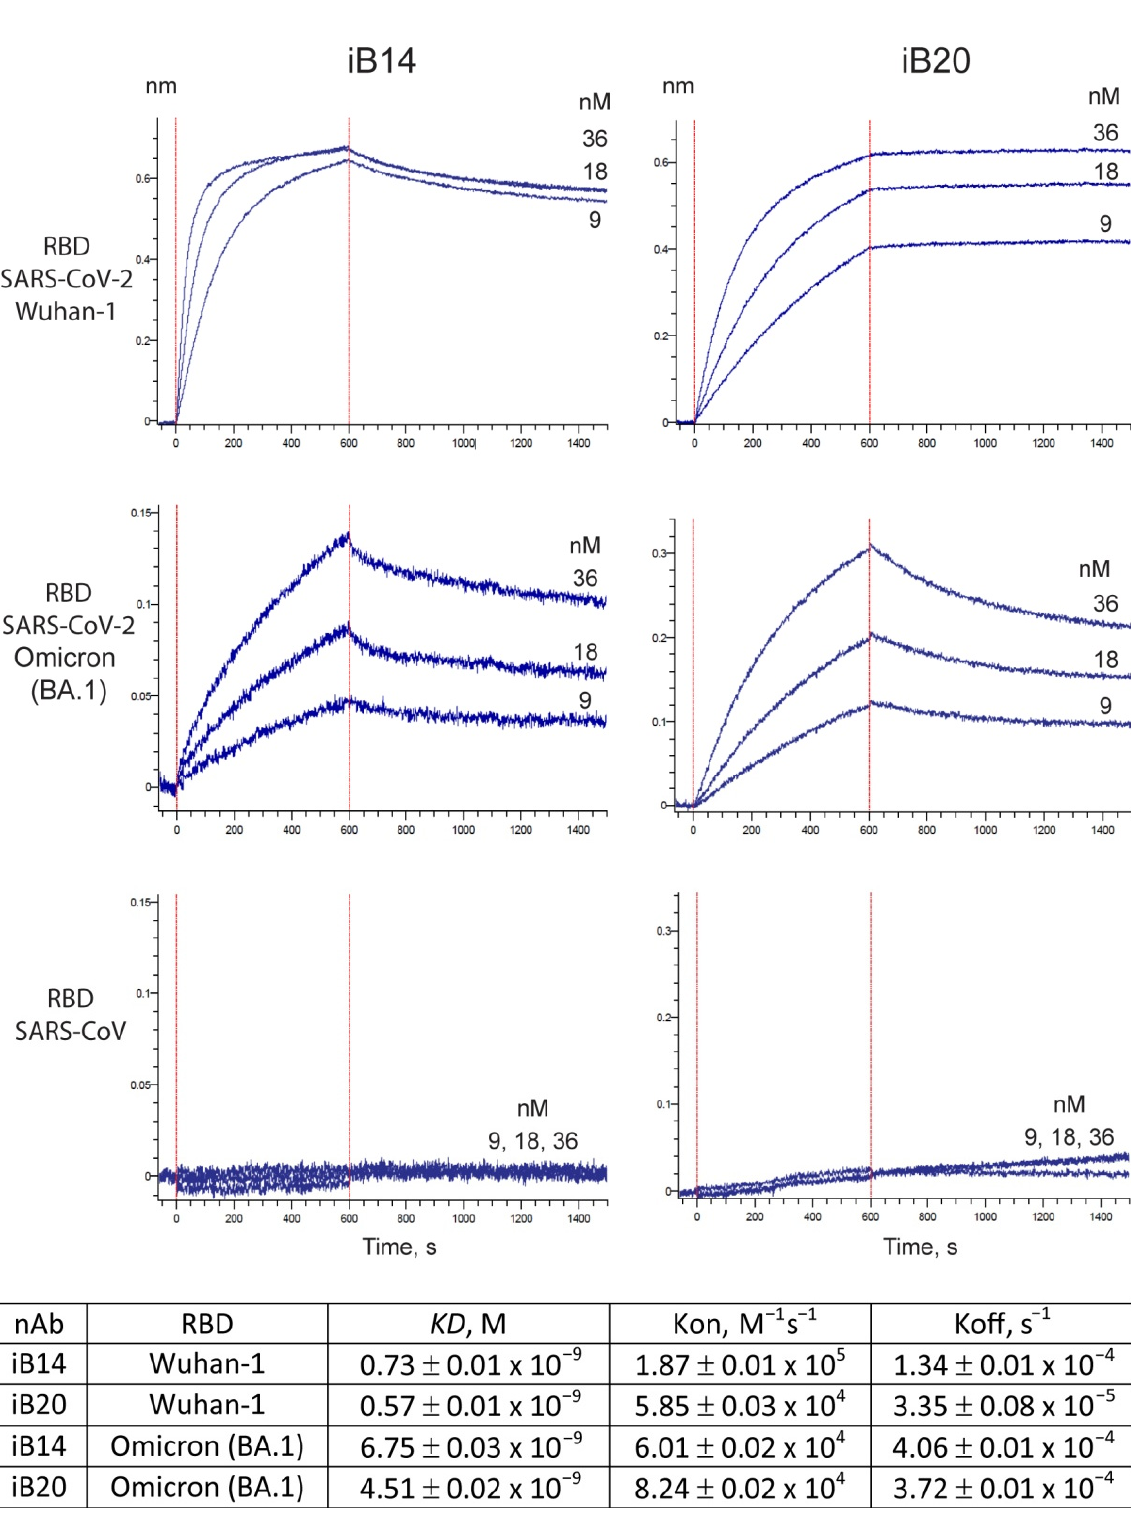
SARS ‐ CoV ‐ 2 Wuhan ‐ 1 or Omicron (BA.1) S protein. iB14 was found to display a ~50 ‐ fold reduction in neutralization potency, which dropped from an IC50 3±1 ng/mL to 174±47 ng/mL (Figure 2A). This is in line with the observations made for the VH1 ‐ 58 class of nAbs that iB14 belongs to [6,8]. In striking contrast, iB20 displayed an order of magnitude